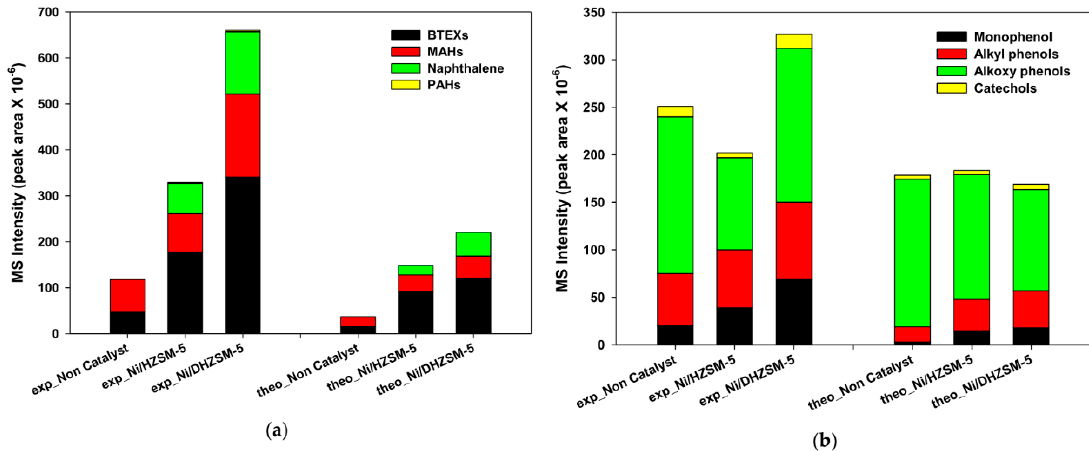
Figure 3. Metal-modified ZSM-5 for catalytic pyrolysis upgrading of biomass [12].